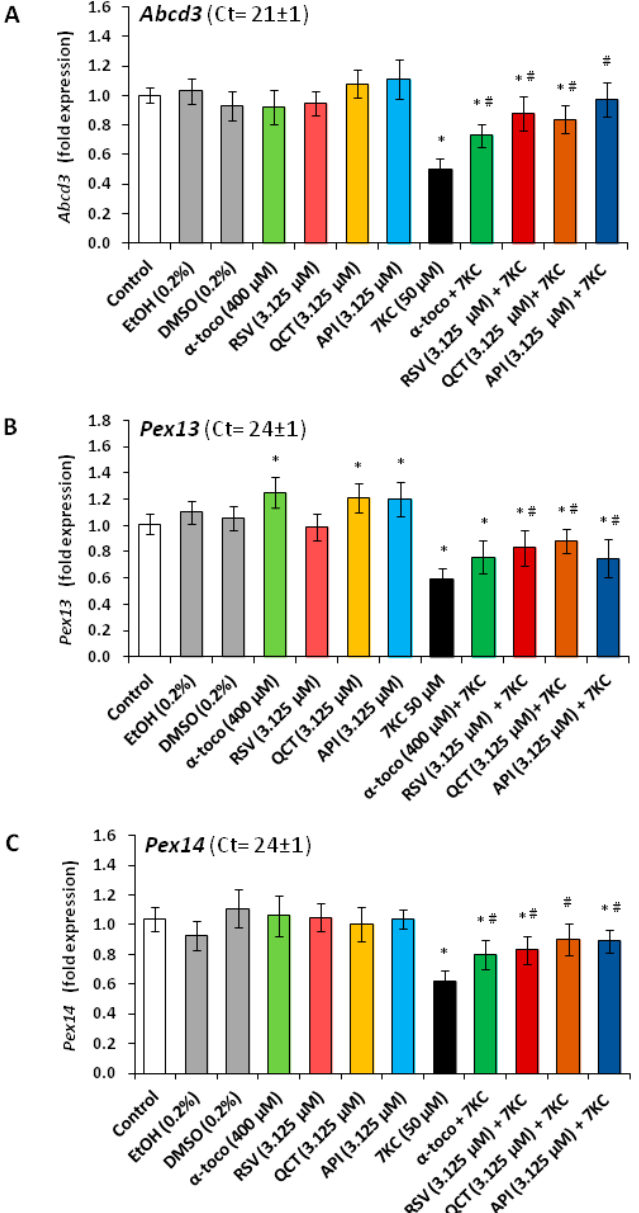
Figure 9. Effect of resveratrol, quercetin, apigenin or α -tocopherol on 7KC-induced changes of peroxisomal mass and biogenesis: measurement of the mRNA levels of Abcd3 , Pex13 and Pex14 by real time-quantitative polymerase chain reaction. N2a cells were cultured for 48 h with or without 7-ketocholesterol (7KC, 50 µM) in the presence or absence of α -tocopherol ( α -toco: 400 µM) used as a positive control for cytoprotection, or with polyphenols: resveratrol (RSV), quercetin (QCT) or apigenin (API) used at a concentration of 3.125 µM. The relative expression of Abcd3 ( A ), Pex13 ( B ), and Pex14 ( C ) mRNAs was determined by real time-quantitative polymerase chain reaction (RT-qPCR). In untreated cells, the cycle threshold (Ct) values are provided for each gene studied: Abcd3 (Ct = 21 ± 1), Pex13 (Ct = 24 ± 1), and Pex14 (Ct = 24 ± 1). Data shown are mean ± standard deviation (SD) of two independent experiments conducted in triplicate. Significance of the differences between control (untreated cells) and RSV-, QCT-, API-, α -toco- or 7KC-treated cells; Mann–Whitney test: * p < 0.05 or less. Significance of the differences between 7KC-treated cells and (7KC + (RSV, QCT, API or α -toco))-treated cells; Mann–Whitney test: # p < 0.05 or less. No significant differences were found between control and vehicle-treated cells (Ethanol (EtOH): 0.2% and DMSO: 0.2%).